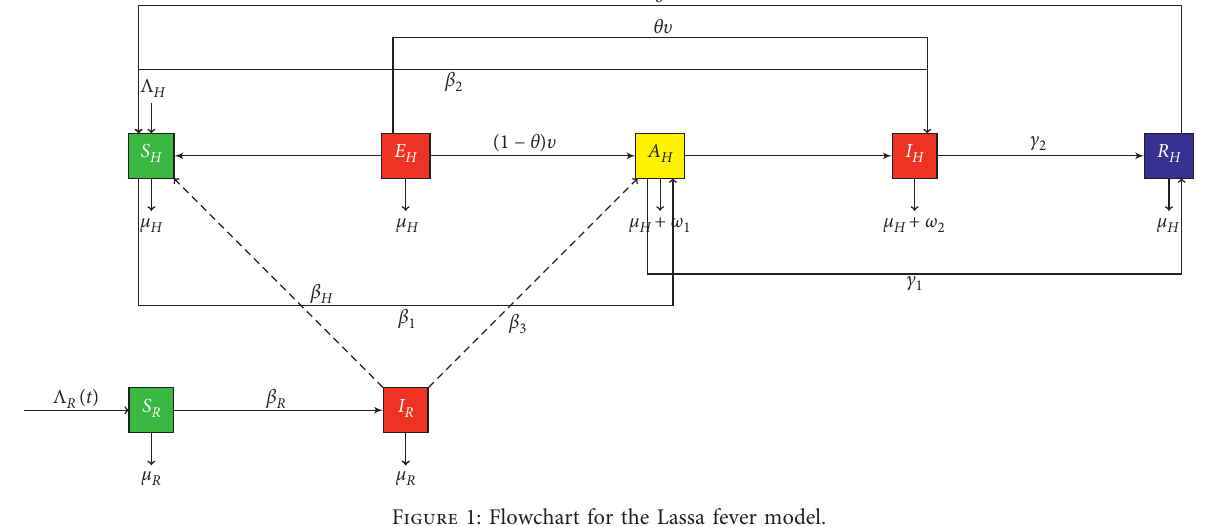
Figure 1: Flowchart for the Lassa fever model.